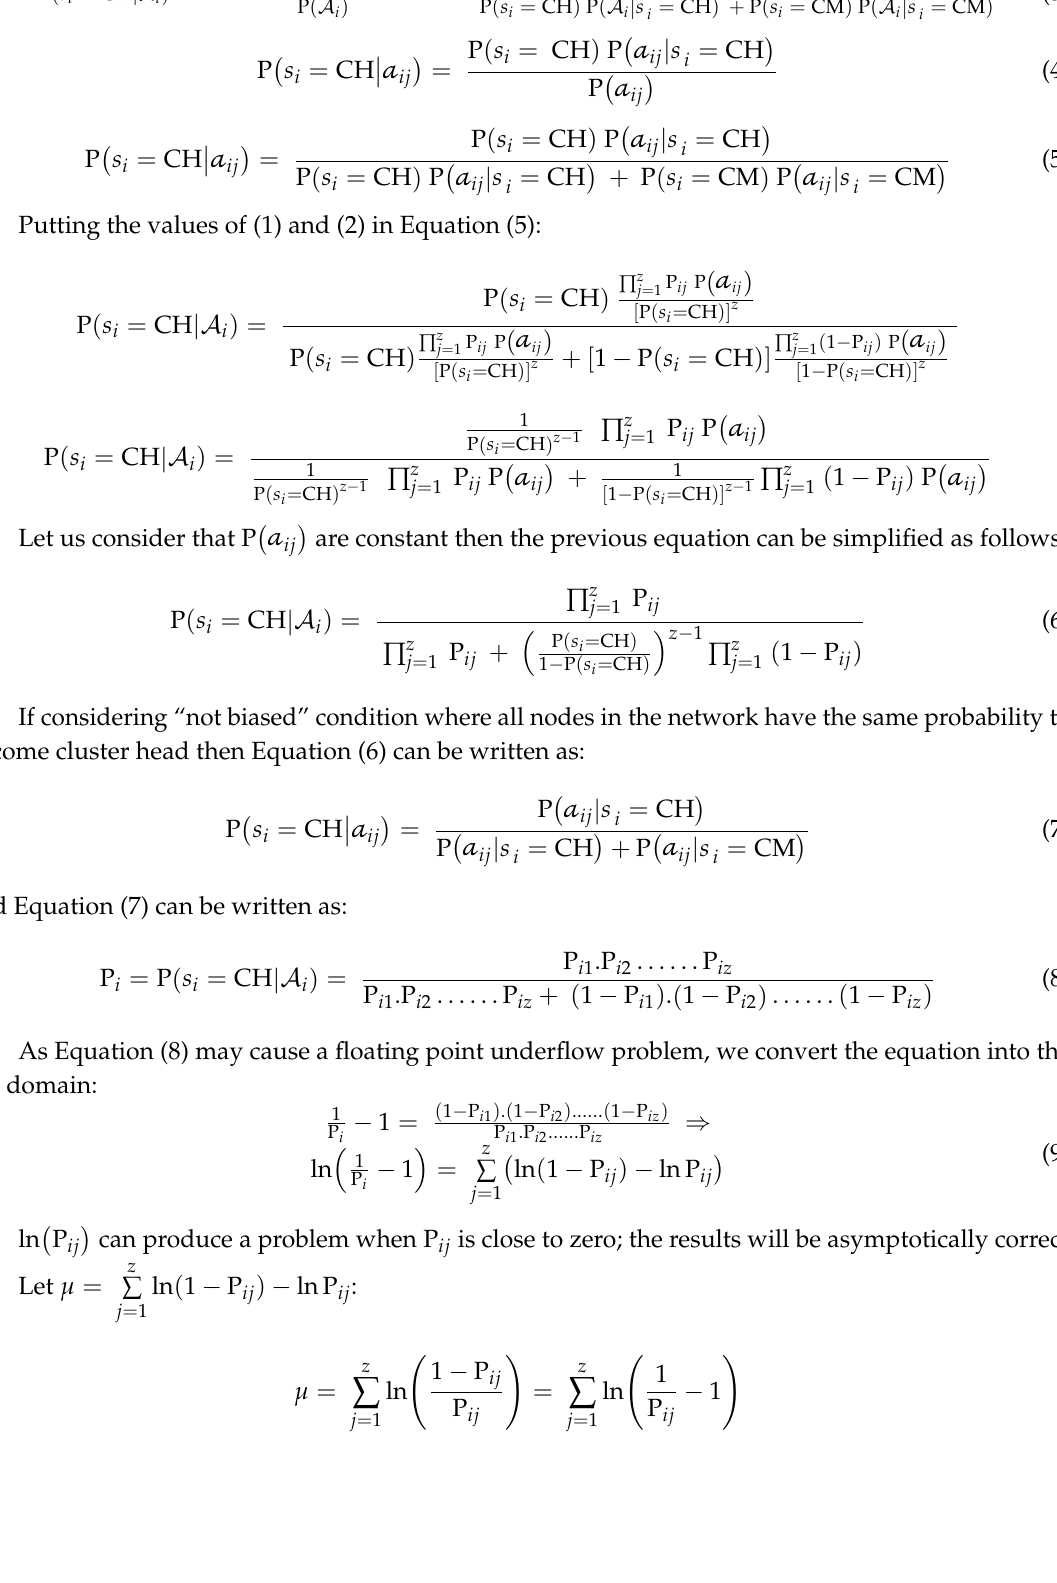
Figure 4. Dynamic clustering scheme.